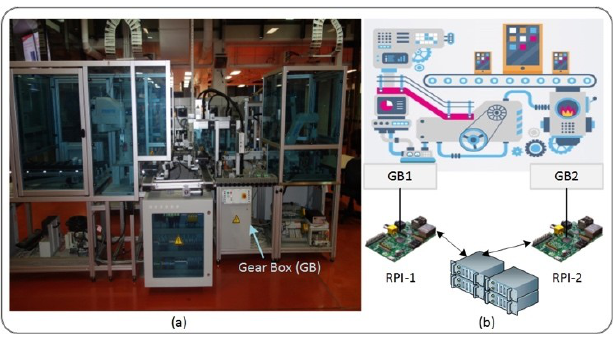
Figure 10. ( a ) Festo-based food processing plant demonstrator; ( b ) deployment diagram of the test bed.